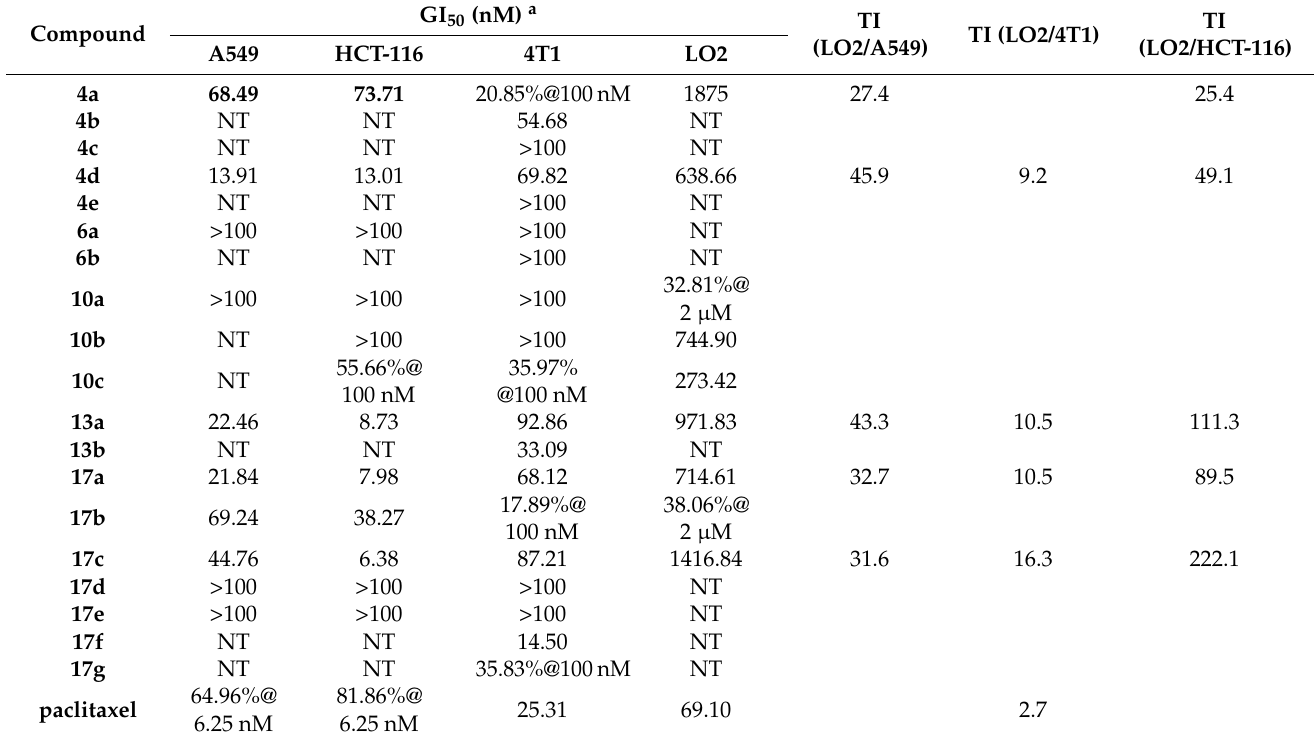
Table 2. Inhibitory activity against tumor cells A549, HCT-116, 4T1 and normal cell